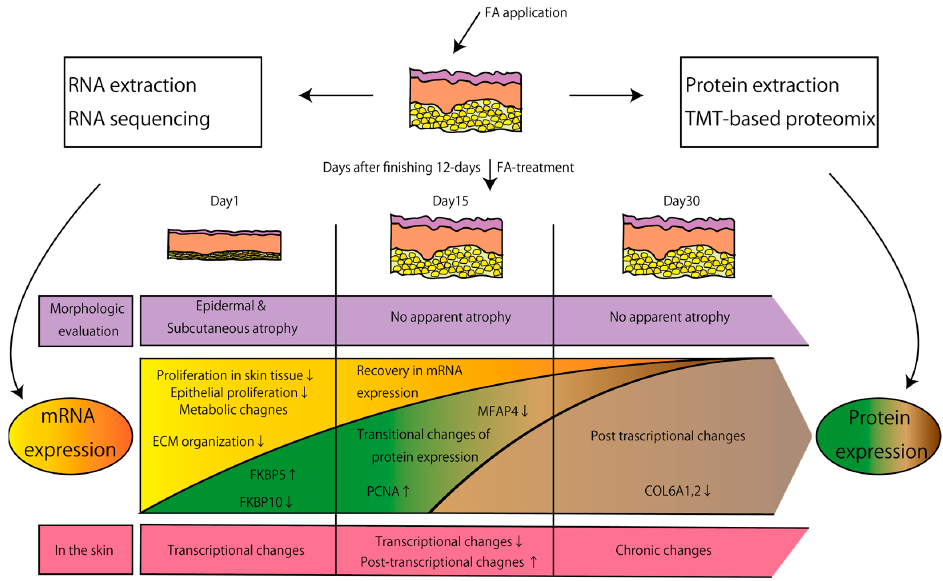
Figure 4. A summary of the current study.